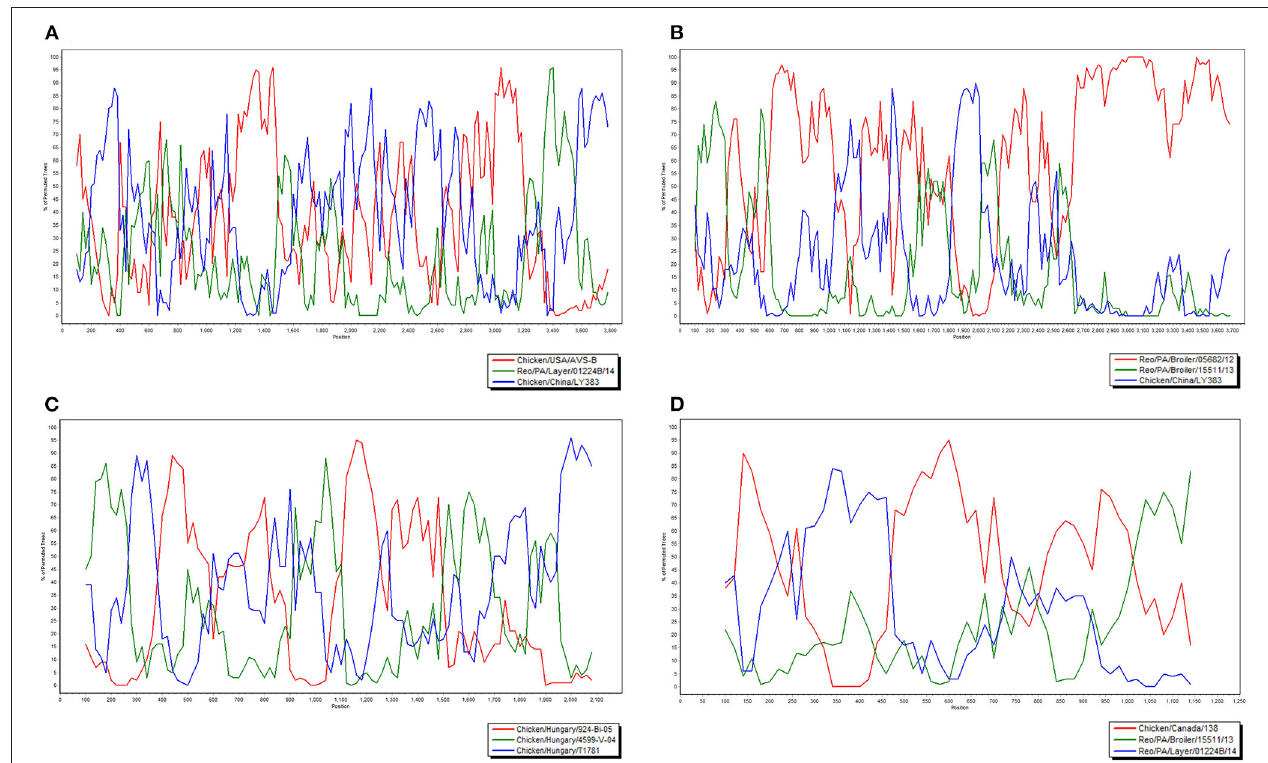
FIGURE 5 | Bootscan analysis of AHZJ19 for detecting intra-segmental recombination. The Bootscan analysis was constructed using the neighbor-joining method (a Kimura two-parameter applied and 100 replicates) with Simplot program version 3.5.1. Query-Chicken/China/AHZJ19; (A) λ A, (B) λ B, (C) µ A, and (D) σ